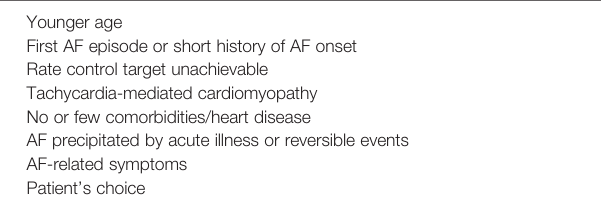
TABLE 1 | Factors favoring the rhythm control strategy, adapted from the 2020 European society of cardiology guidelines for the diagnosis and management of atrial fi brillation (AF)